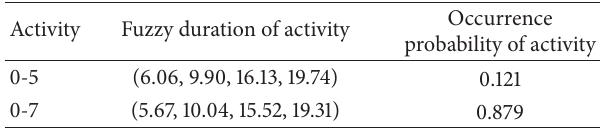
Table 9: Results of Hashemin’s